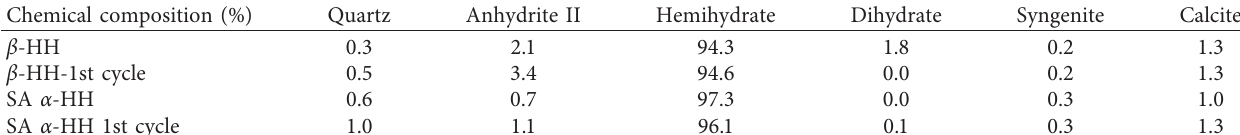
Table 1: Chemical composition of pure β -HH and SA α -HH before and after the first cycle. Chemical composition (%)